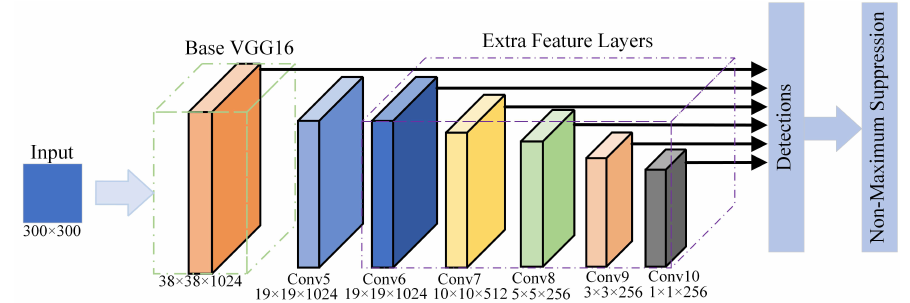
Figure 1. Structure of SSD